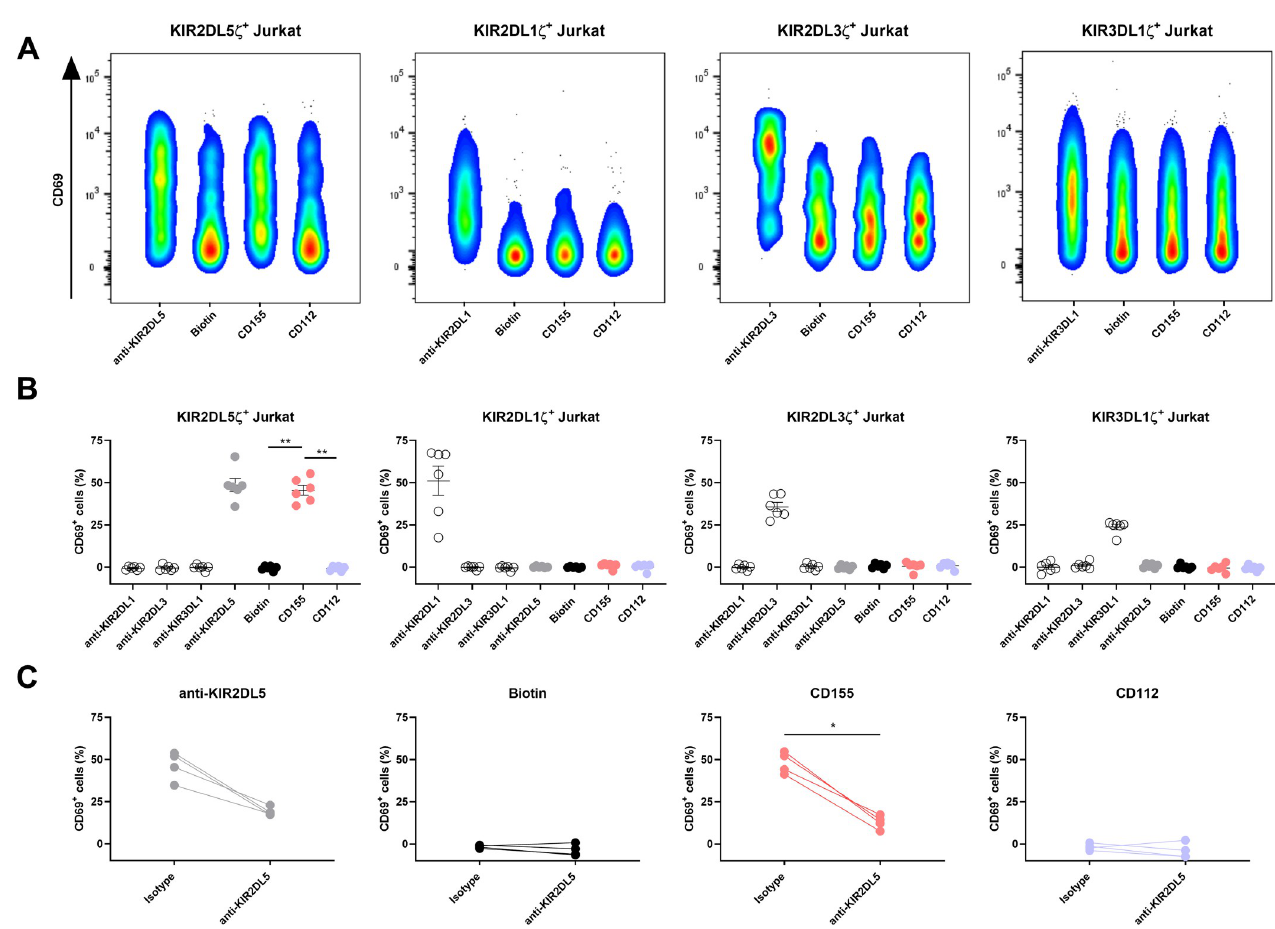
Fig 2. KIR2DL5 z -expressing reporter cells are activated by interacting with CD155. (A) Reporter cell activity was determined by the upregulation of CD69 on the surface of KIR2DL1 z , KIR2DL3 z , KIR2DL5 z and KIR3DL1 z reporter cells during co-incubation with beads coated with anti-KIR2DL1, anti-KIR2DL3, anti-KIR2DL5 or anti-KIR3DL1, respectively, (pos. controls), biotin (neg. control), CD112 or CD155. Plots represent one out of six experiments and only the respective anti-KIR positive control is shown. (B) Percentage of CD69 + reporter cells after co-incubation with the indicated antibodies, biotin and nectin(-like) molecules. Plots show the results of six independent experiments ( n = 6) with the mean value for each condition (black bar) and error bars depicting the standard error of the mean. Background activation (no target control) was subtracted from all samples. Mann-Whitney test was used to statistically analyze the difference in CD69 expression of CD155-, CD112- and biotin-stimulated cells (p = 0.0022). (C) Reporter cell activity of KIR2DL5 z cells was assessed after incubating cells with purified anti-KIR2DL5 or mouse IgG isotype control antibody prior to co-incubation with anti-KIR2DL5-, biotin-, CD155- and CD112-coated beads. The percentage of CD69 + cells following incubation without beads (no target control) was subtracted from all samples. Reporter cell activity was determined in four independent experiments ( n = 4). Lines between dots connect the matching samples incubated with the IgG isotype antibody or with purified anti-KIR2DL5. Mann-Whitney test was used to calculate statistical significance of differences in reporter cell activation through co-incubation with CD155-coated beads with and without KIR2DL5 blocking antibody (p = 0.0286). cells, which do not express CD155 at the cell surface, and transduced 721.221 cells overexpres- sing CD155 (S3 Fig), was assessed. NK cells of a KIR2DL5A � 001 -positive donor and a donor completely lacking KIR2DL5 genetically were co-cultured with CD155 + or CD155 - target cells, and CD107a expression levels on KIR2DL5 - and KIR2DL5 + NK cells served as readout for NK cell degranulation in response to the different target cells (Fig 3A). All NK cell populations (KIR2DL5 - , KIR2DL5 + and NK cells from KIR2DL5 -negative donors) showed increased CD107a expression after co-incubation with CD155 - 721.221 cells (Fig 3B). When co-incubat- ing NK cells with CD155 + 721.221 cells, KIR2DL5 + NK cells expressed significantly lower CD107a levels compared to KIR2DL5 - NK cells (p < 0.01) and NK cells of KIR2DL5 -negative